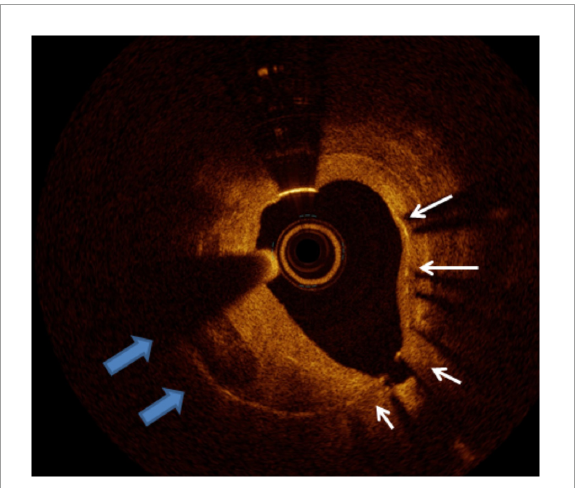
FIGURE11 Calcific neointima. The white arrows mark the stent struts, the left quadrant arc occupied by neointima presenting calcific neoatherosclerosis. The remaining homogeneous neointima is compatible with fibrous tissue.